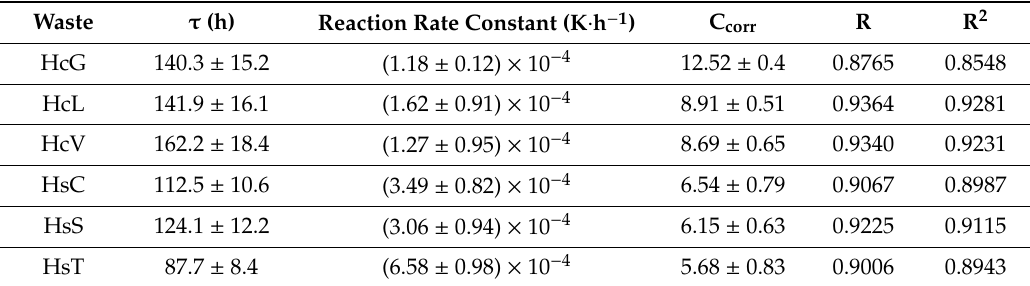
Table 5. Reaction rate constants K and τ , correction factor C corr , correlation coefficient r and multiple determination coefficients R 2 for the fine particle CDWs studied.